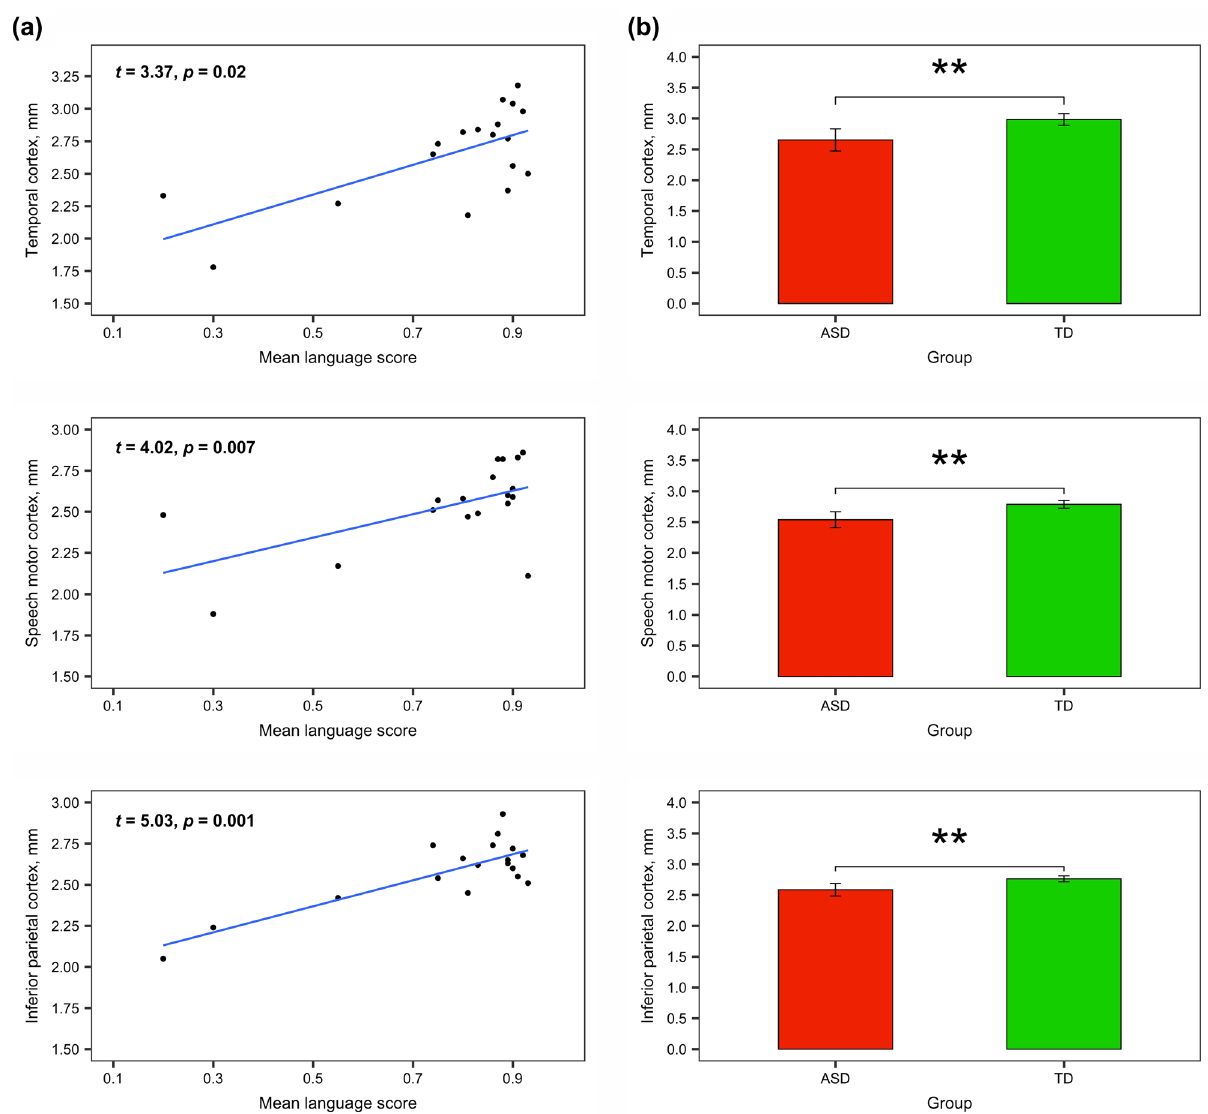
Figure 5. Language-related ROIs analysis (all p -values are Bonferroni-corrected): ( a ) the relationship between GM thickness of language-related ROIs and language abilities of children with ASD; ( b ) the comparison of GM thickness of language-related ROIs between ASD and TD groups of children (significant effects are indicated with * p < 0.05, ** p < 0.01, ns